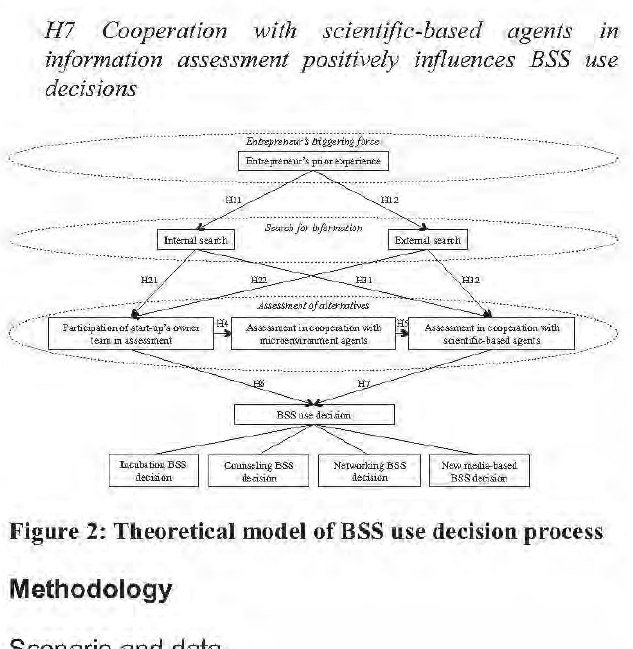
Figure 2: Theoretical model of BSS use decision process